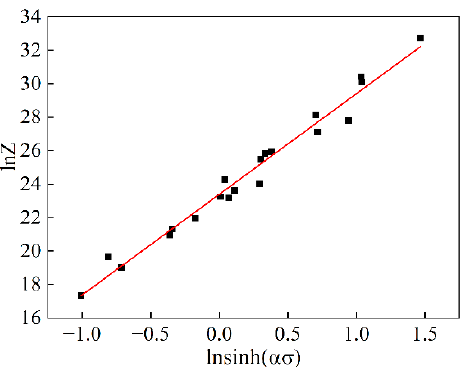
Figure 8. Relationships between Z parameter and flow stress.